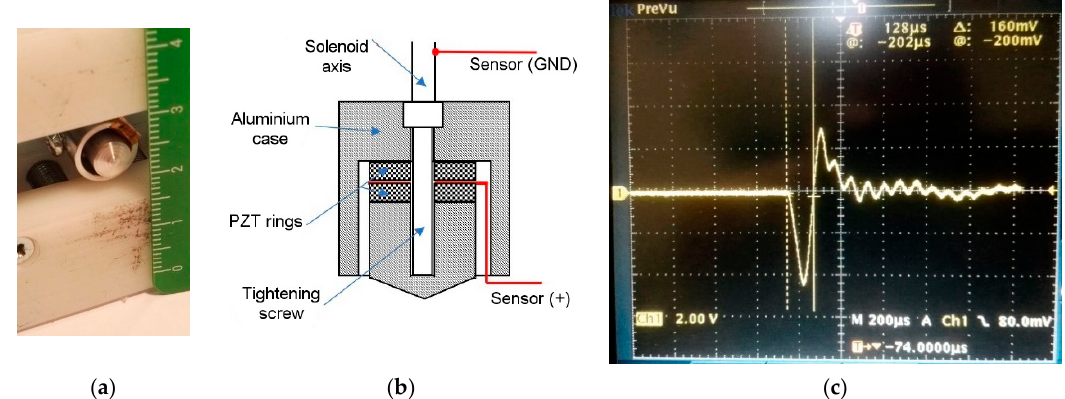
Figure 2. The developed impact force sensor: ( a ) a photo of the sensor; ( b ) a mechanical draw of the sensor, using two PZT rings; ( c ) a scope photo of the signal due to an impact on a “non damaged”